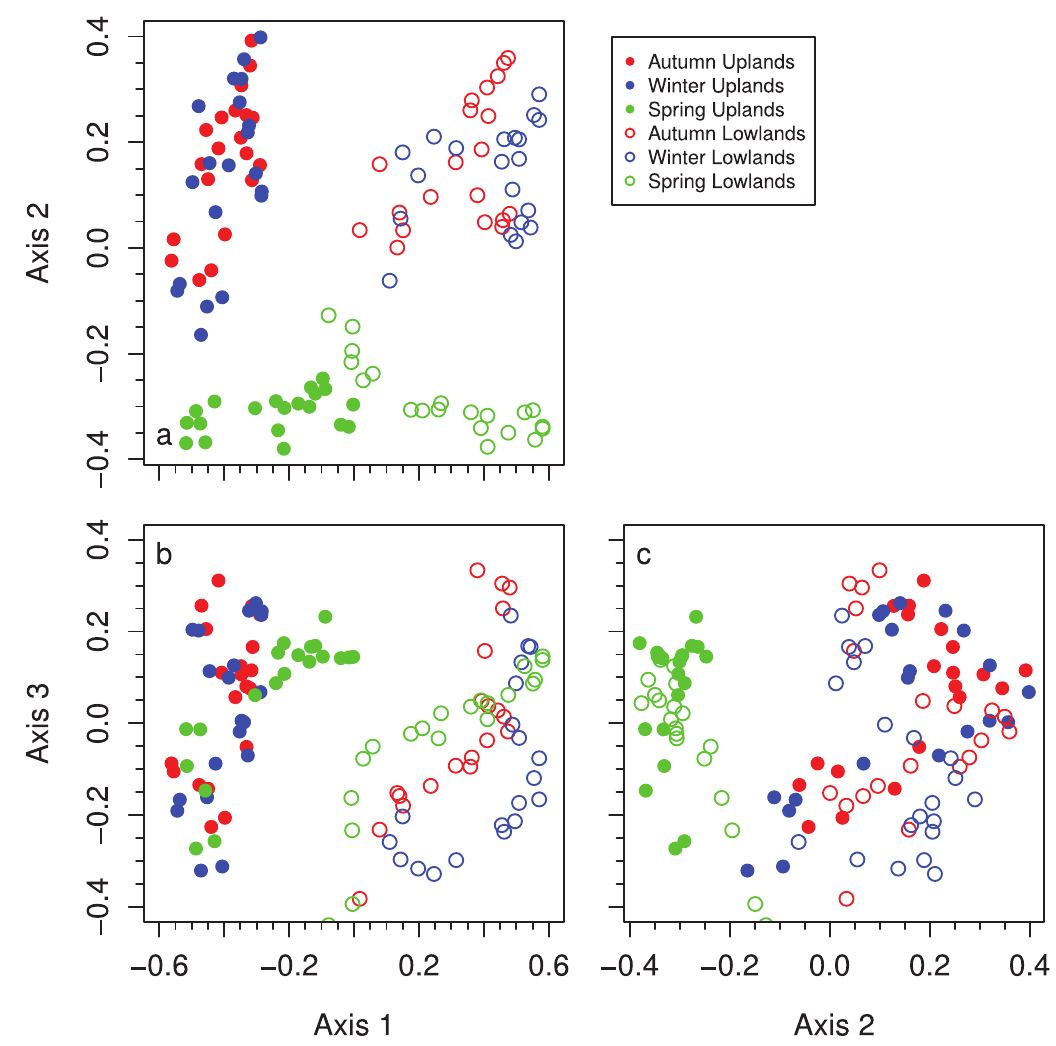
Figure 5. Relationships among NMDS axes of upland (closed circles) and lowland (open circles) grasslands burned in autumn (red), winter (blue), or spring (green). Stress value=0.07 for k=3.